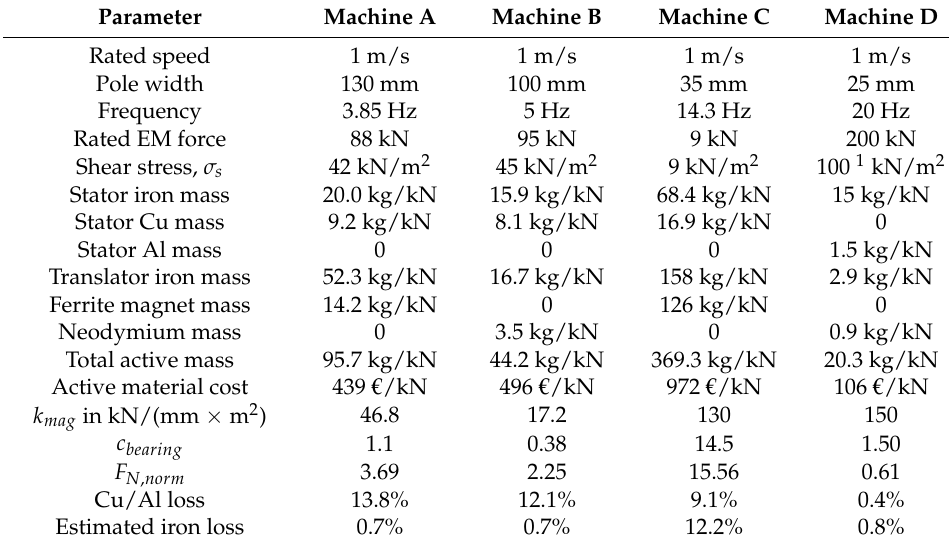
Table 3. Cost and performance comparison of the four machines A–D per kN. Material costs are from Table 2, and should mainly be regarded as a mean of comparison between the different machines, not real